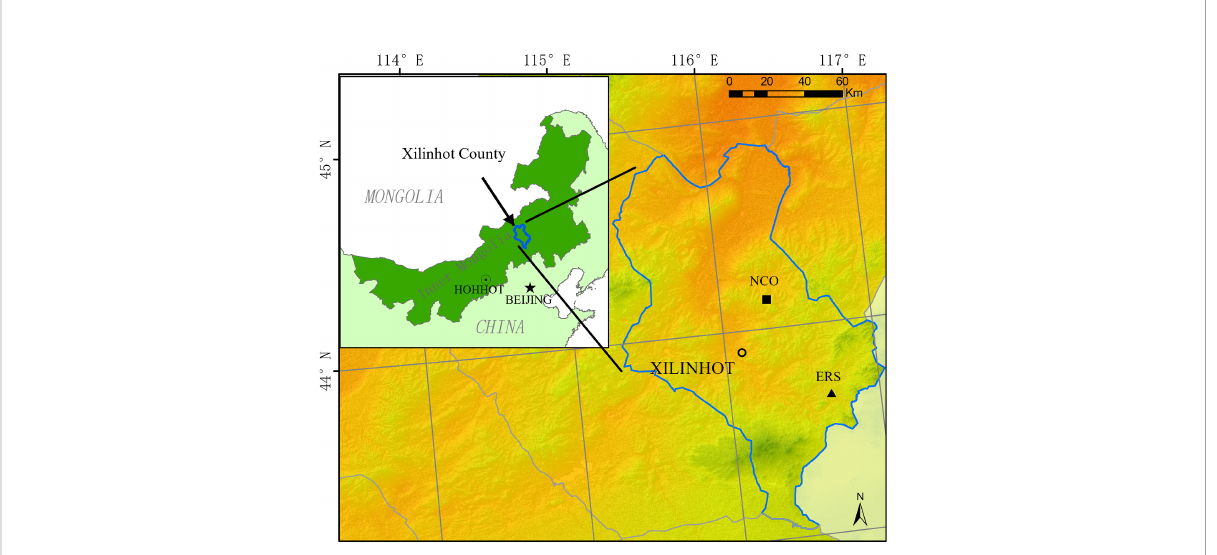
FIGURE 1 Location of the two experimental sites (ERS, Inner Mongolia Grassland Ecosystem Research Station; NCO, Xilinhot National Climate